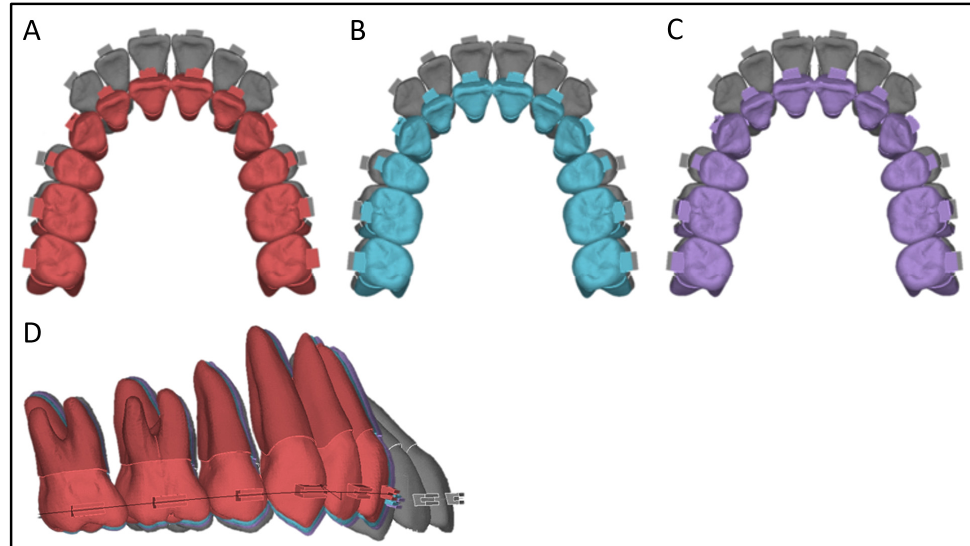
Figure 3. ( A ) Occlusal view of HOMS1 (Red) after space closing; ( B ) Occlusal view of HOMS2 (Sky) after space closing; ( C ) Occlusal view of HOMS3 (Violet) after space closing; ( D ) Overlap of lateral view at HOMS. Gray-colored teeth, teeth before movement.